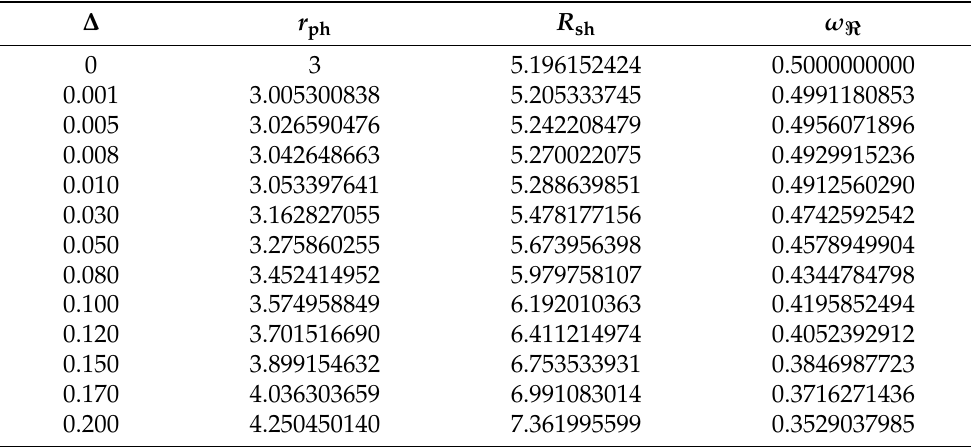
Table 1. The photon sphere radius r ph , the event horizon radius R sh and the real part of quasinormal modes ω (cid:60) , for different values of ∆ , with M = 1 and l = 1.